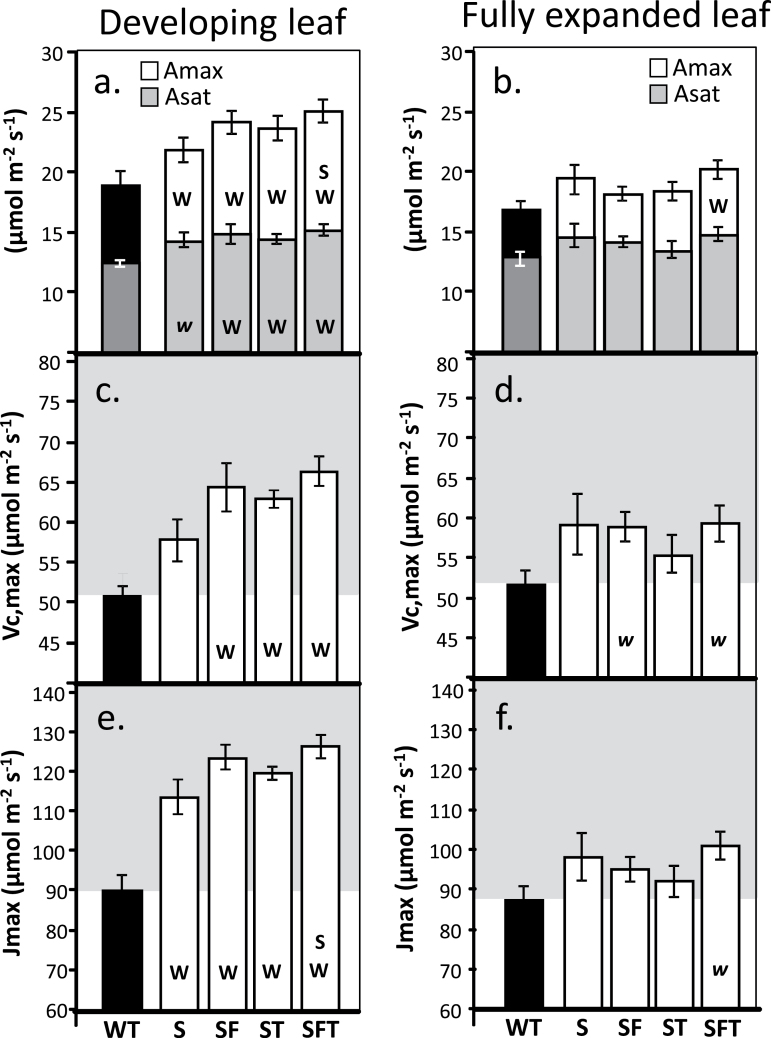
Rubisco activity and J
max derived from A/C
i response curves. These data are derived from the A/C
i response curves shown in Fig. 8 using the equations published by von Caemmerer and Farquhar (1981). Plants were grown in long days for 2 weeks at 200–350 μmol m–2 s–1 light intensity followed by 5 weeks in natural light conditions in the greenhouse at 200–350 μmol m–2 s–1 light intensity. Developing leaves (11–13cm leaves) and fully expanded leaves. Values represent four plants from either 3–4 independent lines (12–16 plants) for each transgene set. Significant differences (<0.05) are represented by capital letters. Lower case italic lettering indicates lines that are just below significance (>0.05 and <0.1).